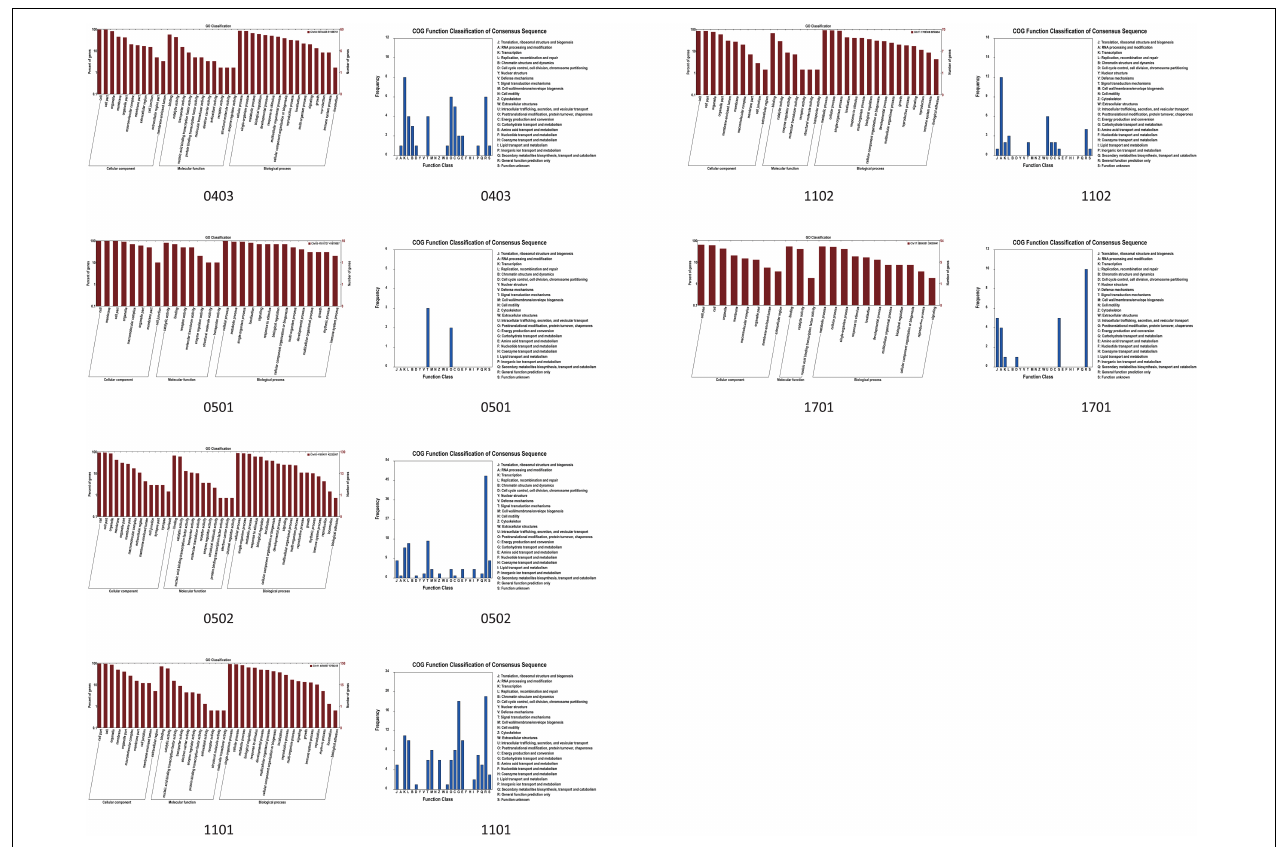
FIGURE 7 | The histogram of function classification of QTL based on the GO and Clusters of Orthologous Groups of proteins (COG) database (the number 0403 refers to the region of qDAE0403, qDA0403, qGLU0403, qAGL0403, and qTIF0403. The number 0501 refers to the region of qAGL0501. The number 0502 refers to the region of qDA0502, qDAE0502, qGLU0502, and qTIF0502. The numbers, 1101, qq02, and 1702, refer to the region of qPRO1101, qGL1102, and qOIL1702, respectively).